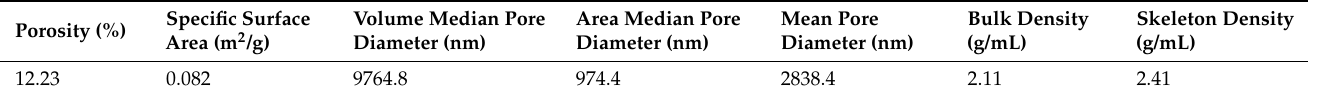
Table 2. Basic pore parameters of sandstone samples.